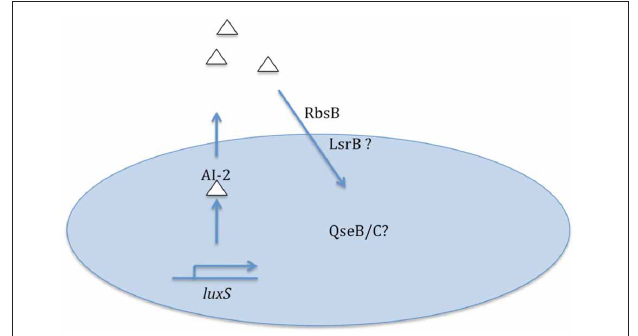
FIGURE 1 | Summary of data and some remaining questions regarding nontypeable H. influenzae quorum